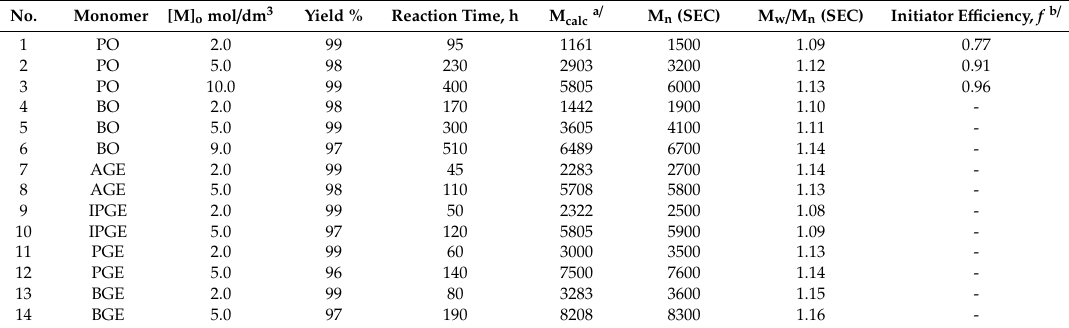
Table 1. Characterization of polyether-diols prepared with K-DPG activated by 18C6 as an